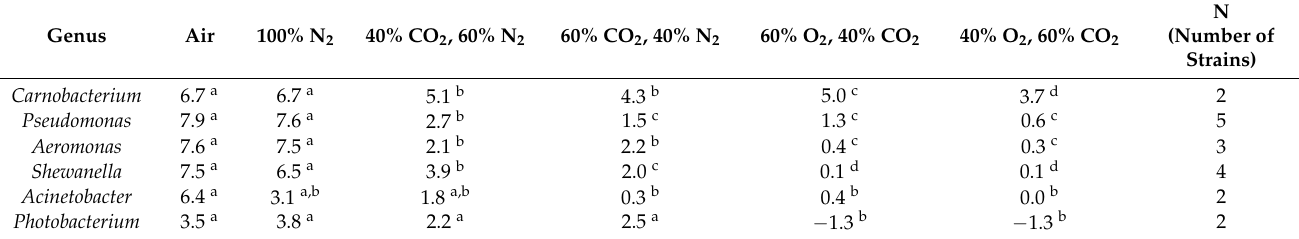
Table 3. Growth screening of bacterial strains. Two–five strains (N) per genus were tested. Logarithmic change in bacterial numbers after 21 days of 4 ◦ C storage on cod agar trays inoculated with selected bacteria strains under different atmospheric conditions. Mean values for 2–5 strains for each genus (from Table A1) are given. Positive numbers indicate growth. For each row, entries with the same letter attached to them are not significantly different at the 0.05